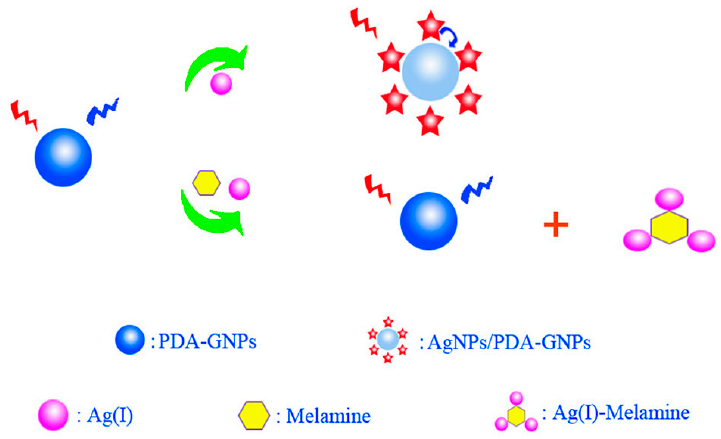
Figure 11. Schematic illustration of the sensing mechanism of melamine in the absence and presence of melamine (reproduced with permission from Reference [71]).